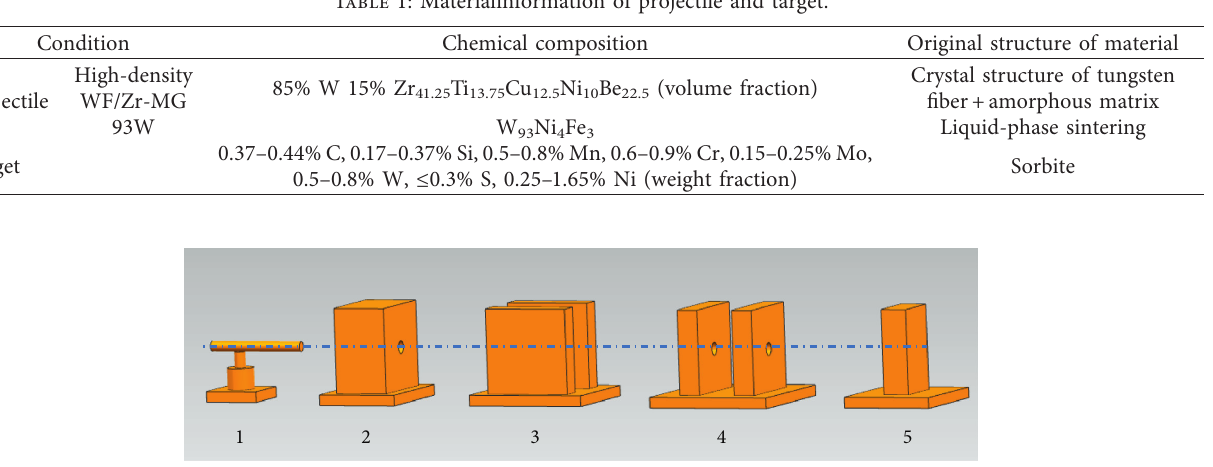
Figure 4: Schematics of the ballistic experiment: 1 is a 30mm ballistic gun, 2 is the sabot collector, 3 is a high-speed camera, 4 is a speed measurement system, and 5 is the